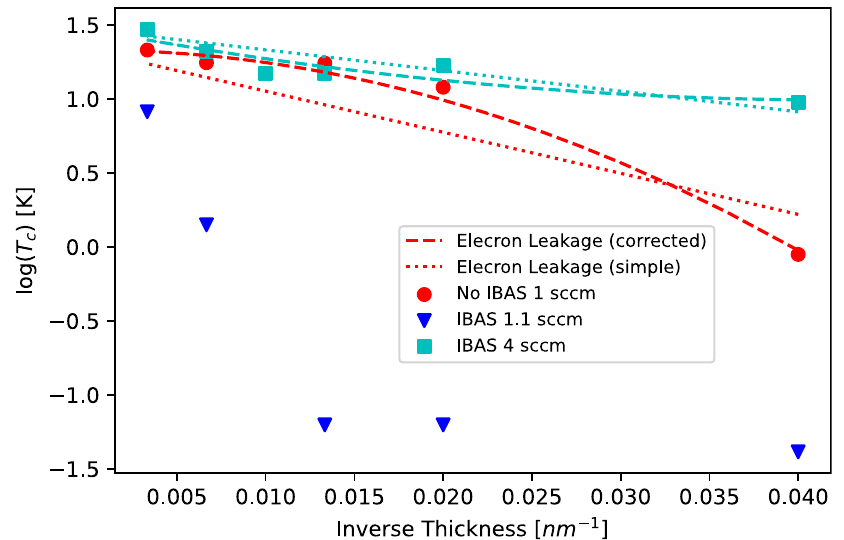
Figure 4. Dependence of superconducting T c on inverse film thickness consisting of different nitrogen flows. Experimental data are plotted in red circles (non-IBAS) contrasted with blue triangles and cyan squares (IBAS). Lines show best fits of different models: The dotted lines are a fit of Eq. (3) and the dashed lines corresponds to a fit of Eq. (4). The 1.1 scc IBAS films do not follow either